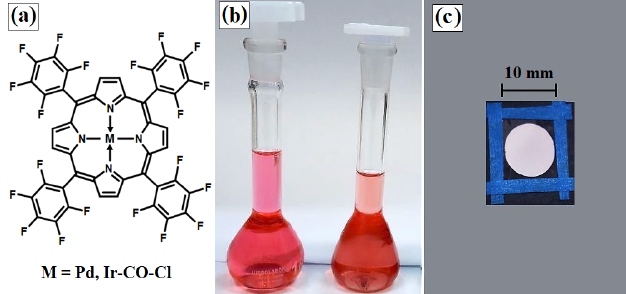
Figure 1. ( a ) Structural formula of the metalloporphyrins under study; ( b ) PdTFPP (left) and IrTFPP-CO-Cl (right) dissolved in CHCl 3 and ( c ) polystyrene